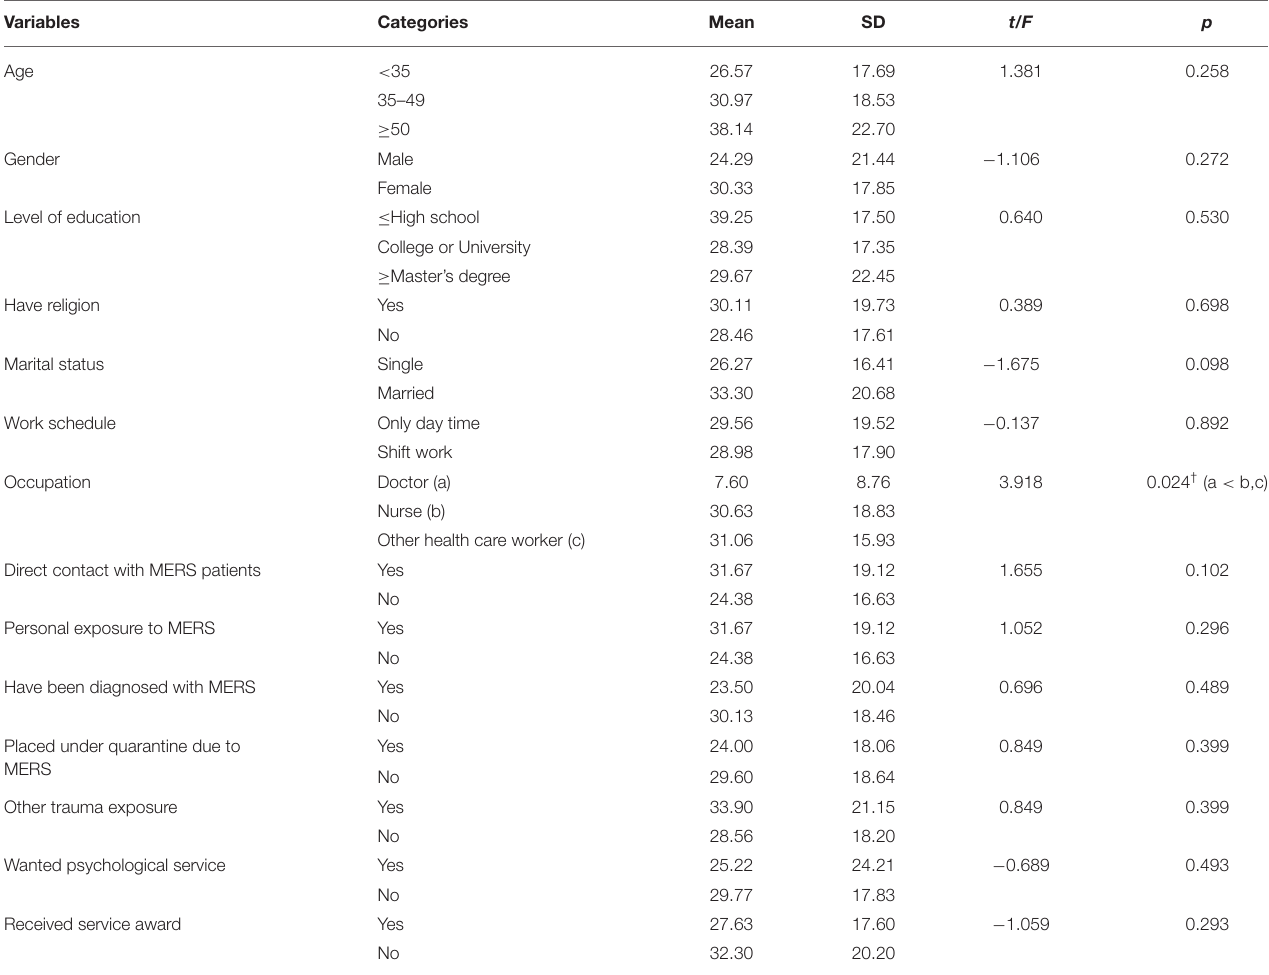
TABLE 5 | Comparison of PTG according to participant characteristics ( N = 78).